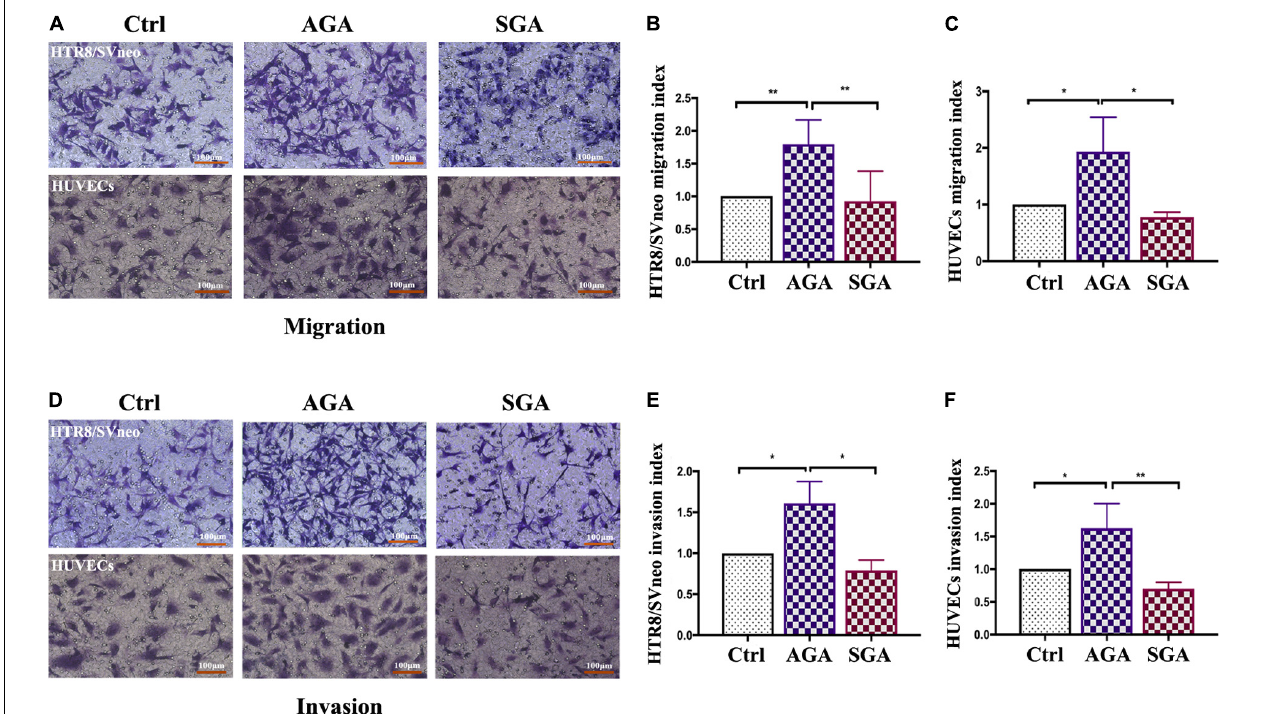
FIGURE 6 | dNK cells in the SGA group attenuated the migration and invasion ability of trophoblasts and HUVECs. (A,D) Transwell assay results showing migrating (A) , or invading (D) , trophoblasts that reached the lower part of the filter membrane under the indicated conditions (Ctrl/AGA/SGA: with complete medium/with dNK from AGA/with dNK from SGA in the lower chamber, respectively). (B,C,E,F) Migration index (B,C) , or Invasion index (E,F) (number of migrated cells/the corresponding control). Statistical analysis was based on the results of six independently repeat experiments. * p < 0.05, ** p < 0.005. Scale bars represent 100 µ